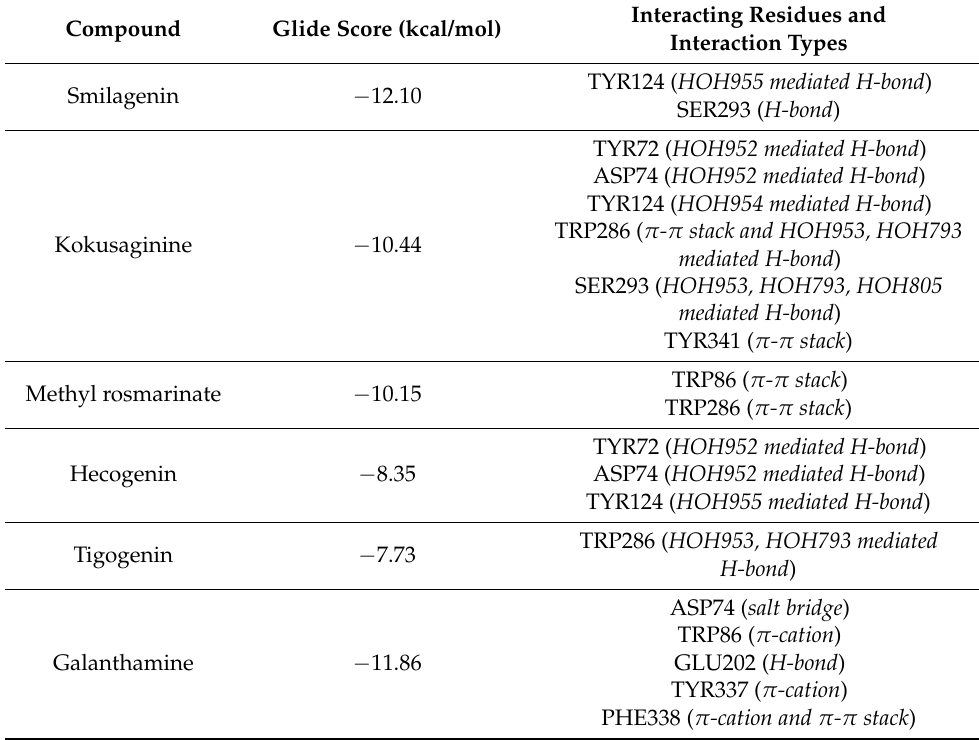
Table 2. Molecular interactions of the compounds docked with hAChE active site